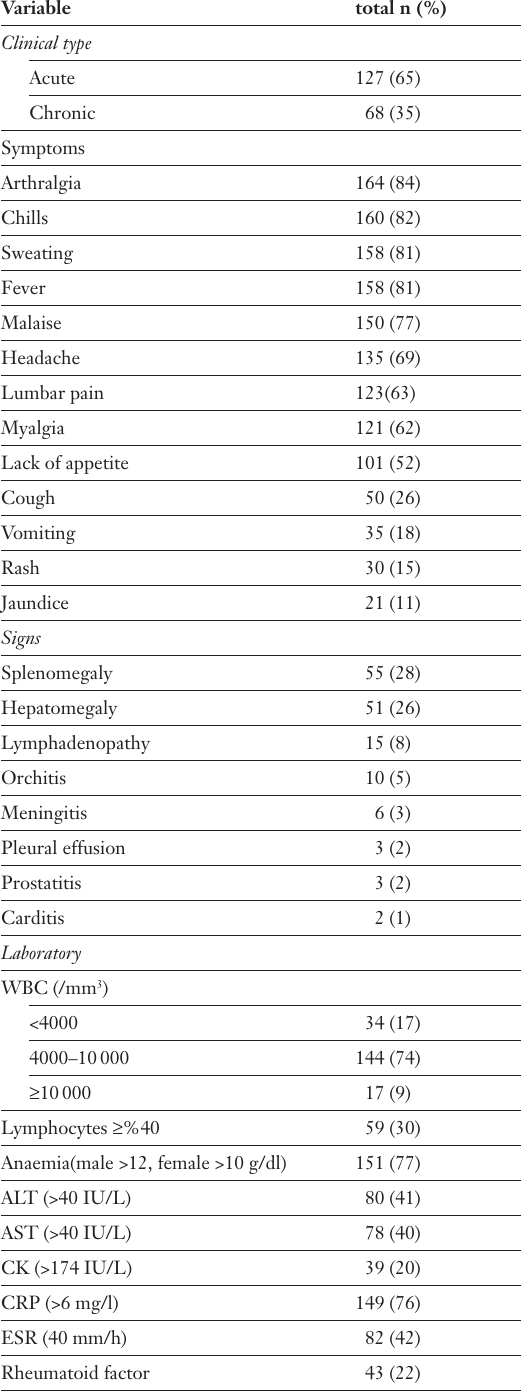
Symptoms, signs and laboratory at initial examination in 195 patients with musculoskeletal